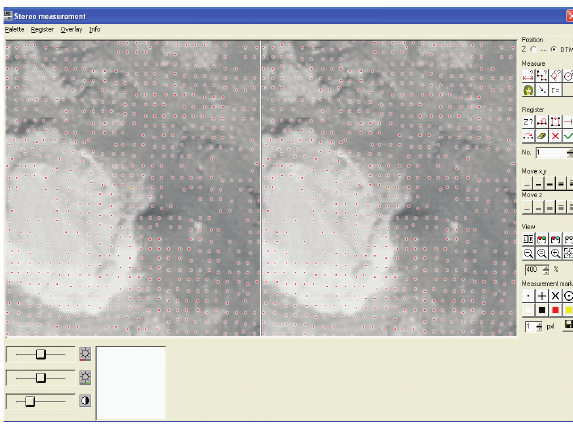
Fig. 3. Terrain model fragment – stereoscopic